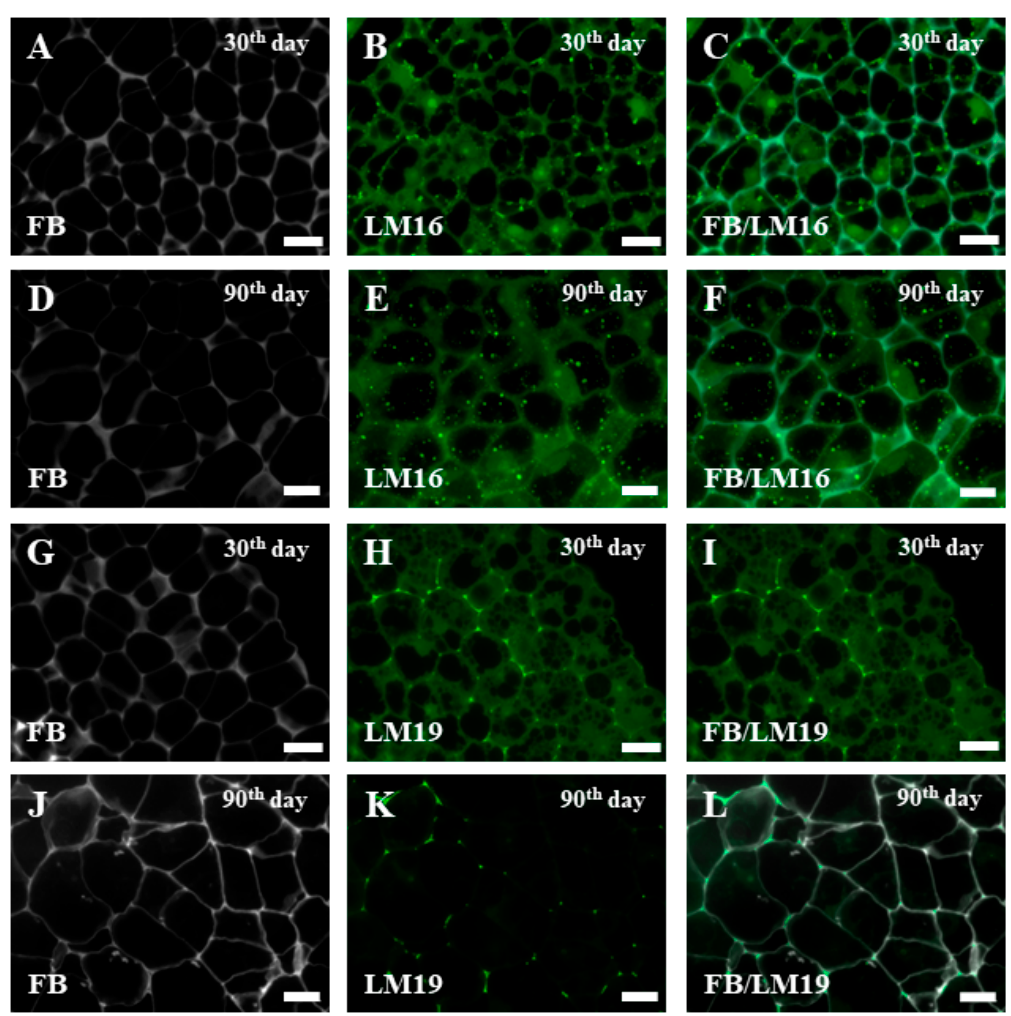
Figure A4. Immunolocalisation of LM16 ( A – F ) and LM19 ( G – L ) in B. distachyon callus. ( A – C , G – I ): 30th day of cultivation; ( D – F , J – L ) 90th day of cultivation. The greenish background on these photomicrographs is due to autofluorescence. Scale bars, 10 µ m.